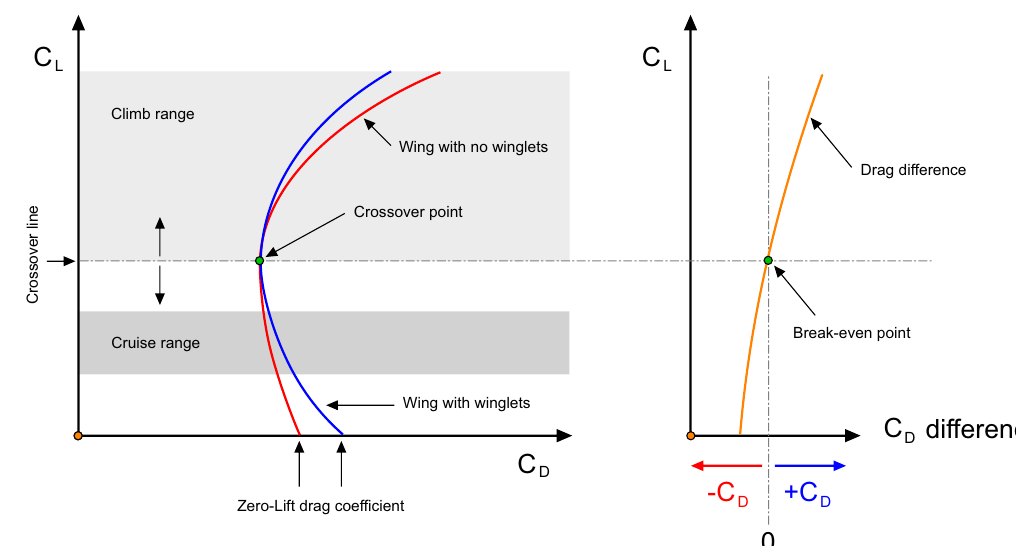
Figure 5. Comparison of drag polars for a clean wing and a wing with winglet installed, where C D is the drag coefficient and C L is the lift coefficient. In the left image, the light grey area represents the climb range of the wings, and the dark grey area represents the cruise range of the wings. In the right image, we show the drag difference, where negative C D means drag increment and positive C D means drag reduction. The C D difference is expressed as the C D subtraction between the wing with winglets and the wing with no winglets.